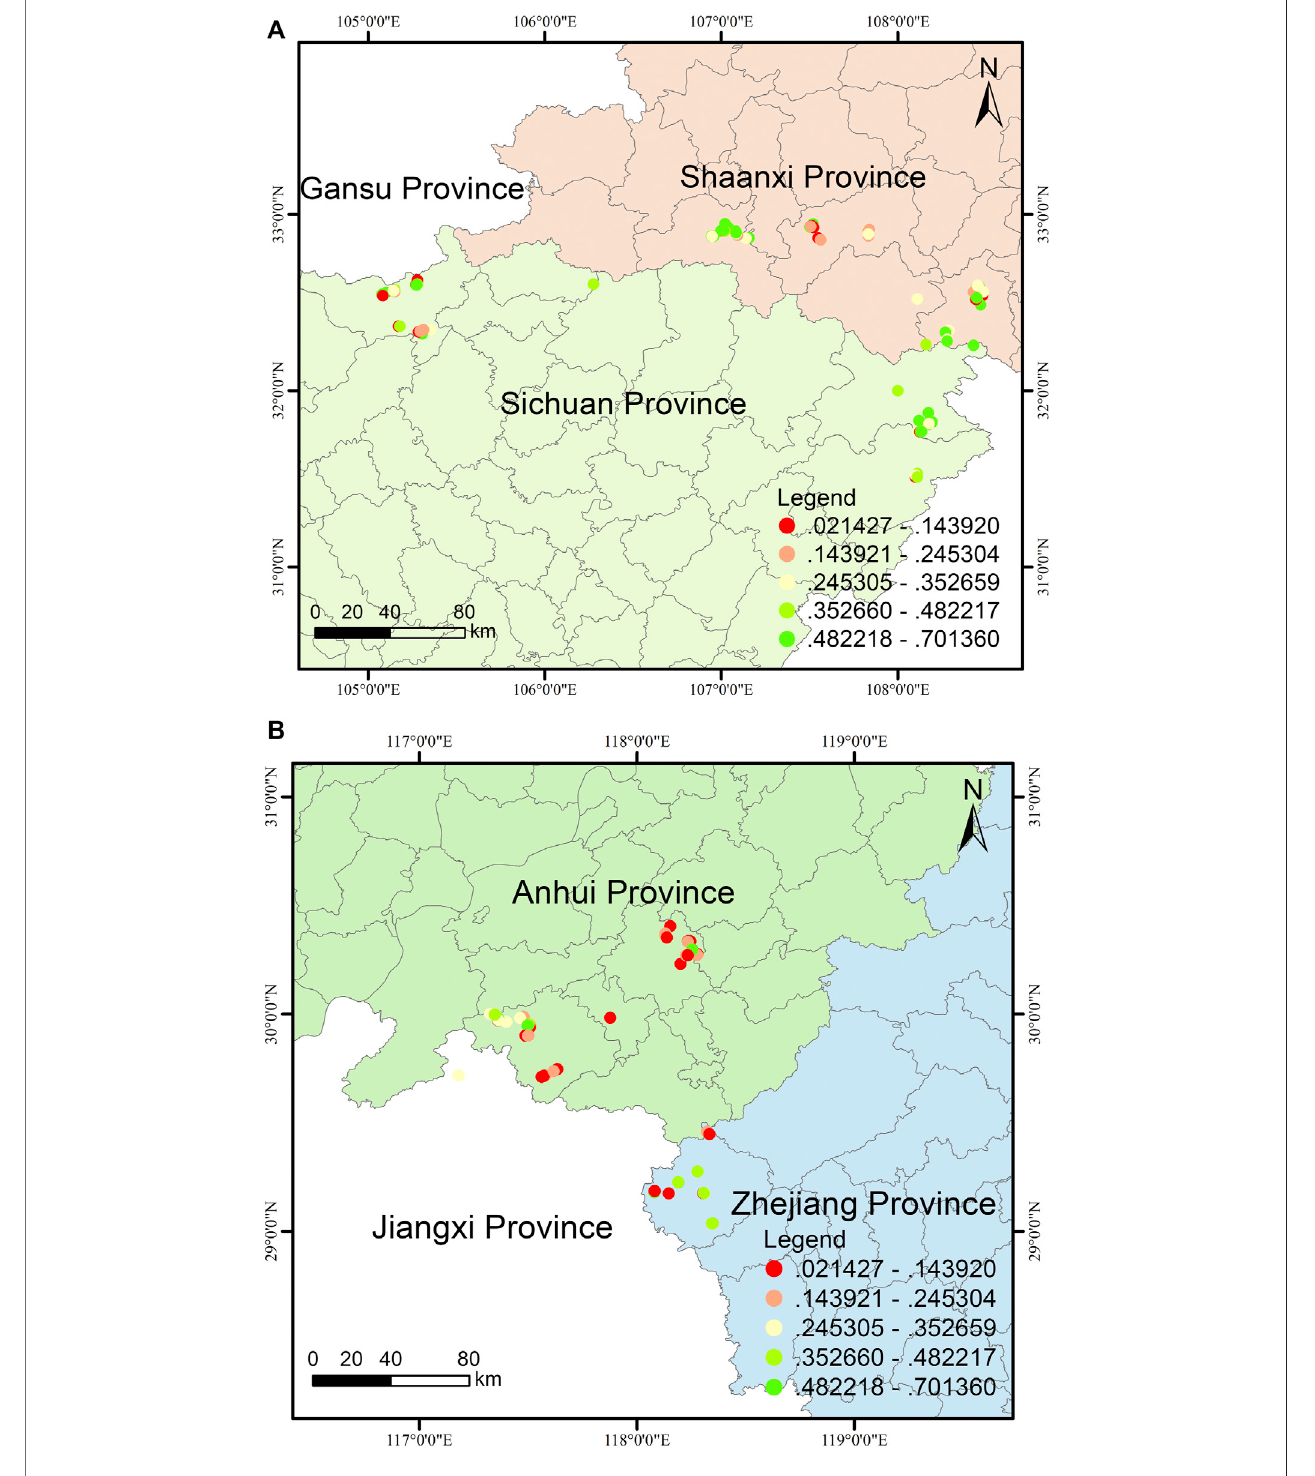
FIGURE 3 | Spatial aggregates of farmers ’ green or non-green production behavior: (A) Qinba Mountain and (B) Huangshan Mountain.